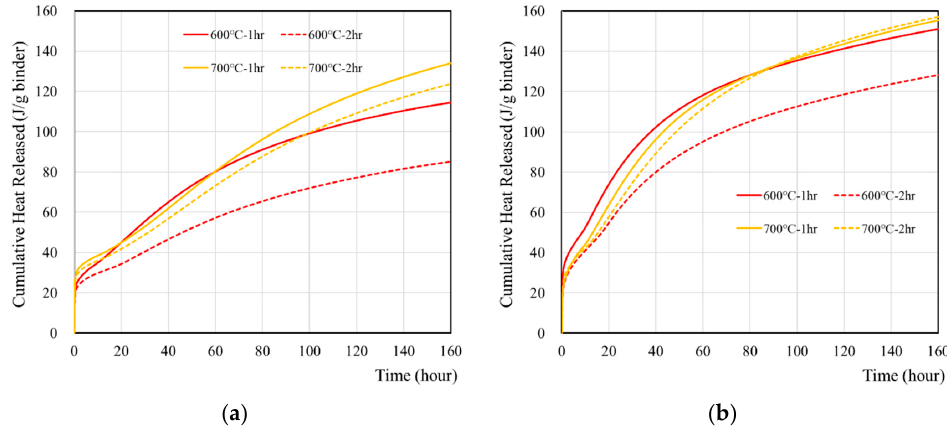
Figure 3. Cumulative heat of wasteforms containing various types of liquids: ( a ) with deionized water, ( b ) with 1 M CsCl solution. Table 5. The seven-day cumulative heat flow of wasteform made of recycled cement powder and 1 M CsCl solution.